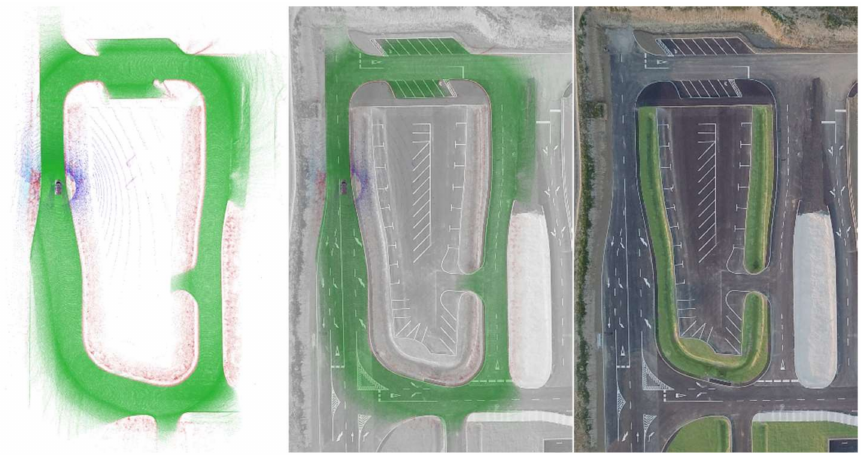
Figure 9. On the left side, the result is visible: road (green) and the sidewalk (red). In the middle, a mixture of the measurement and a drone image is displayed. On the right only the drone image is visible (location: Zalaegerszeg, Hungary, ZalaZONE).